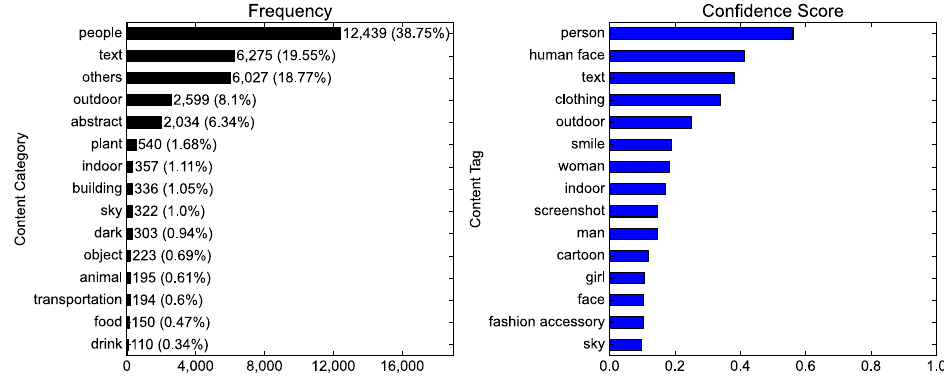
Figure 2. The overall content of the Instagram photos with a #NoMask hashtag: the frequency of photos by content category (left), and the content tags with the highest mean confidence scores (right).